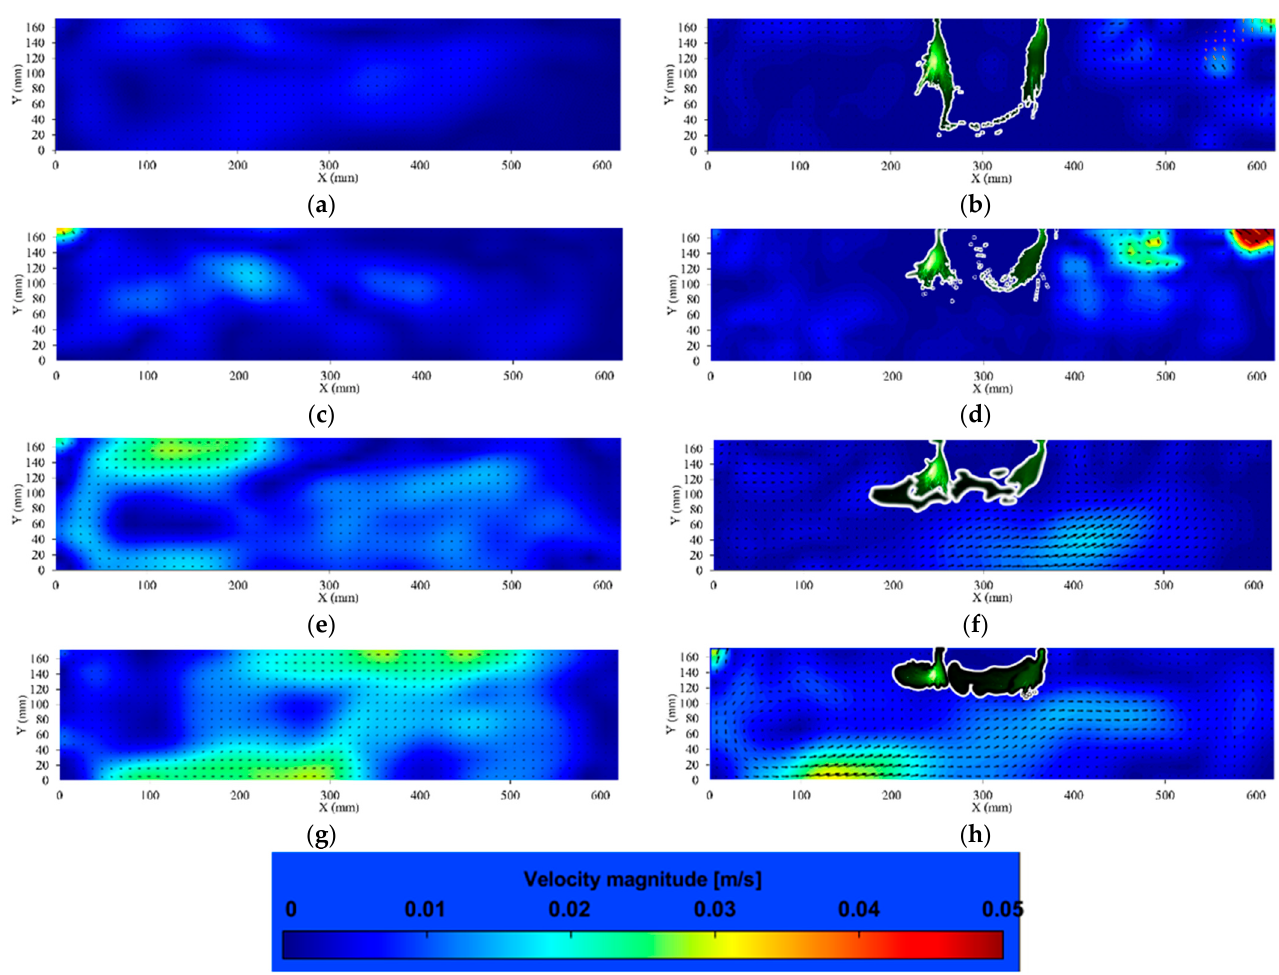
Figure 6. Flow velocity distribution of the flow field in hydroponics under different flow rates. ( a ) 2 L/min (without plants); ( b ) 2 L/min (with plants); ( c ) 4 L/min (without plants); ( d ) 4 L/min (with plants); ( e ) 6 L/min (without plants); ( f ) 6 L/min (with plants); ( g ) 8 L/min (without plants); ( h ) 8 L/min (with plants). The magnetic map of velocity is shown in the figure, blue indicates a velocity of 0 m/s, and red indicates the highest velocity (0.05 m/s).